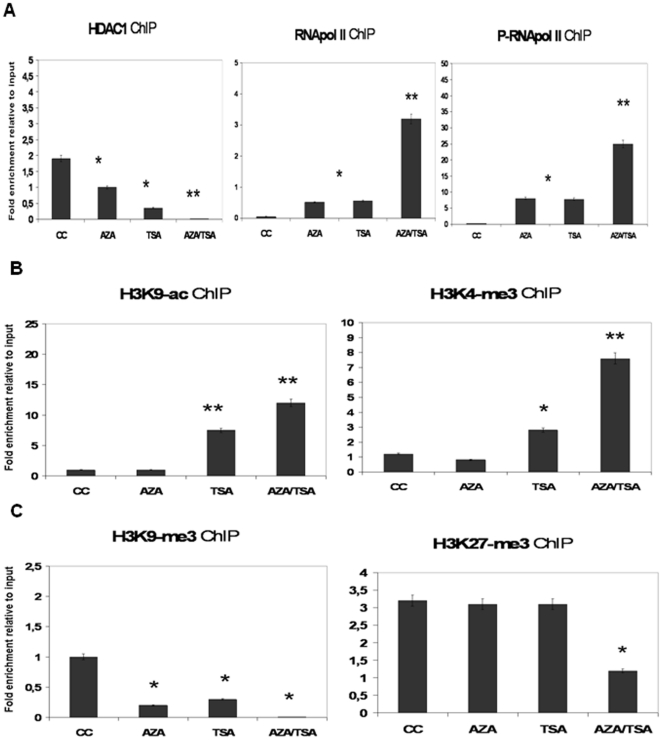

PPARG transcriptional repression is due to specific repressive chromatin marks and recruitment of HDAC1.(A) Quantitative ChIP analysis in HCT116 cells was performed before and after the treatment with AZA and TSA alone or in combination. Native chromatin was incubated with antibodies directed against the indicated proteins. The immunoprecipitated DNA was used as template in qPCR reactions using specific primers for the PPARG promoter region *P<0.05, **P<0.01. (B) ChIP assays were carried out as described above against acetylated H3K9 and trimethylated H3K4 *P<0.05, **P<0.01 or (C) trimethylated H3K9 and H3K27 *P<0.05. The time-points for co-treatments were 72 hs for 5 µM AZA and 24 hs for 300 nM TSA, alone or in combination; CC indicates untreated control cells. Results are the mean values ± SD of three independent experiments, each performed in duplicate.